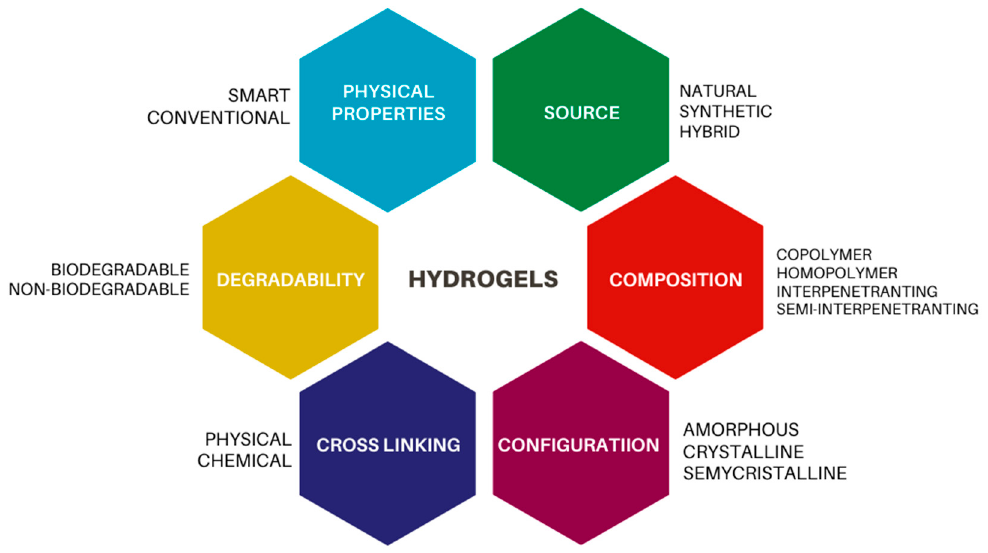
Figure 1. Schematic representation of the hydrogels’ classification (Adapted with permission from Ref. [4] . Copyright 2015, Elsevier).